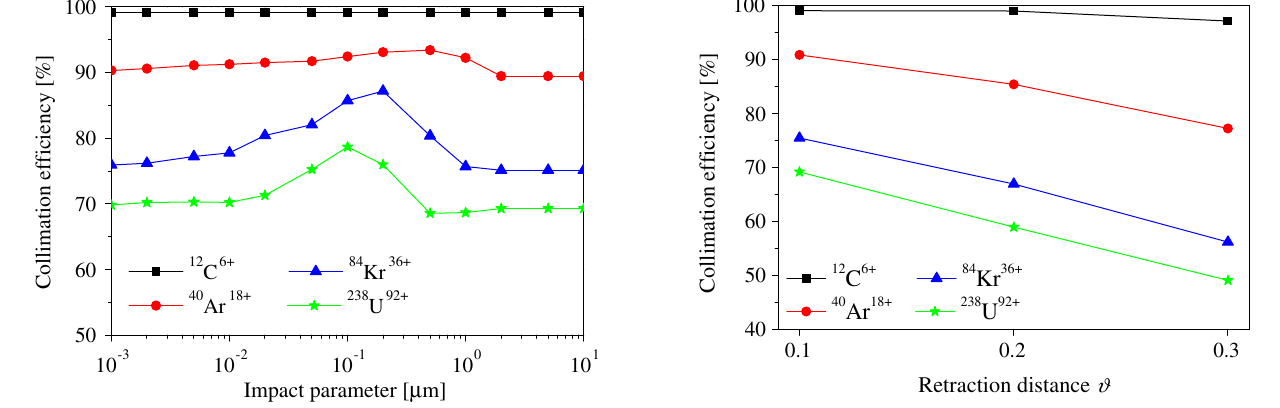
FIG. 8. Influence of the initial impact parameter on the multi- pass collimation efficiency of the halo collimation system (without cryocatchers).